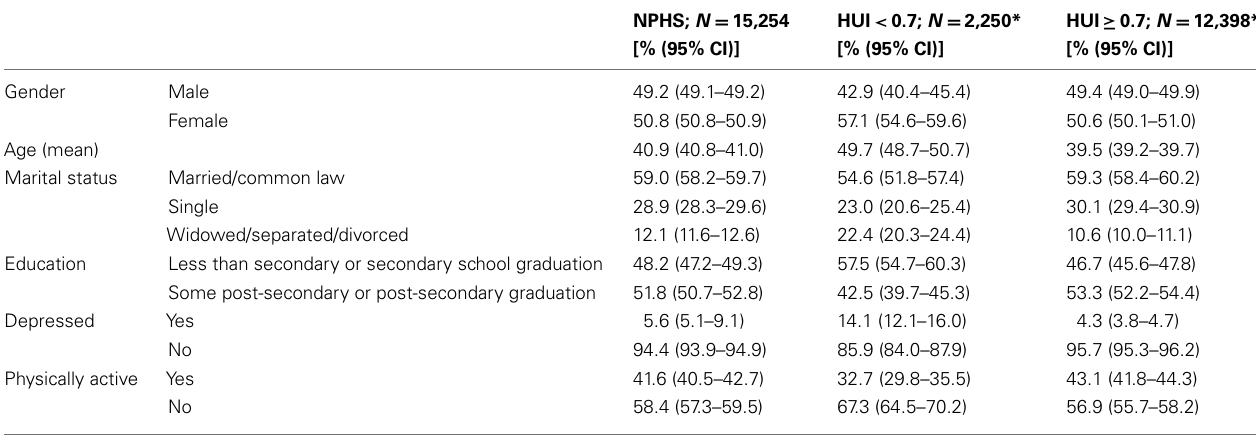
Table 1 | Demographic features of study sample (NPHS) at baseline